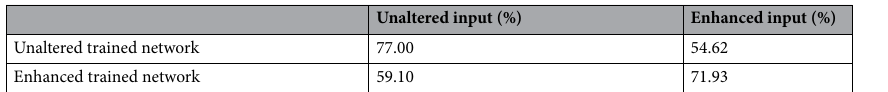
Table 1. Mean average precision of unaltered and enhanced trained networks tested on unaltered and enhanced input images.